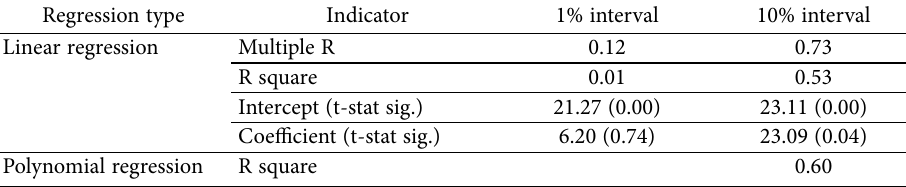
Table 4A. Regression statistics of gross margin mean analysis